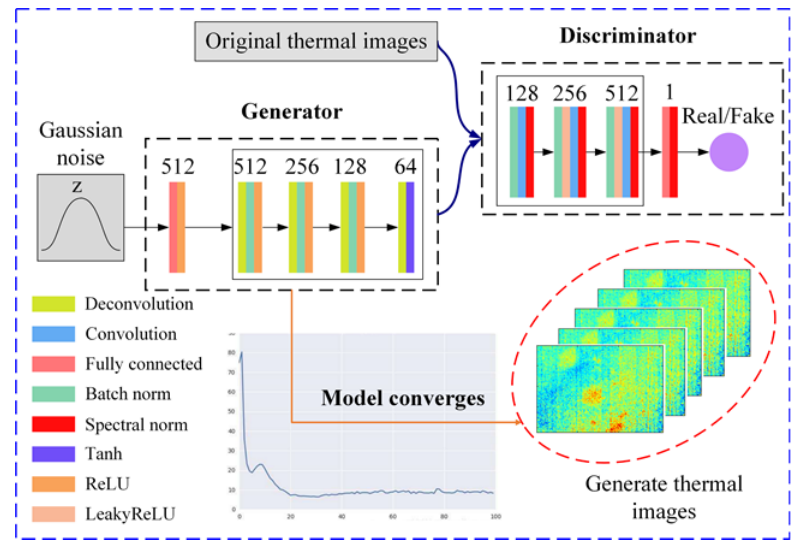
Figure 4. SNGAN data augmentation architecture for thermal image generation.